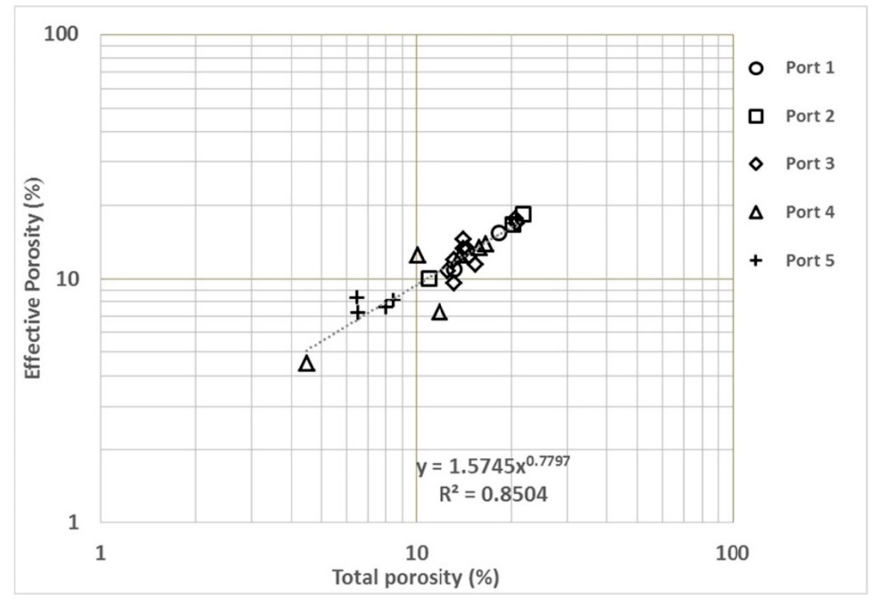
Figure 7. Effective porosity (EP) vs. total porosity (TP).